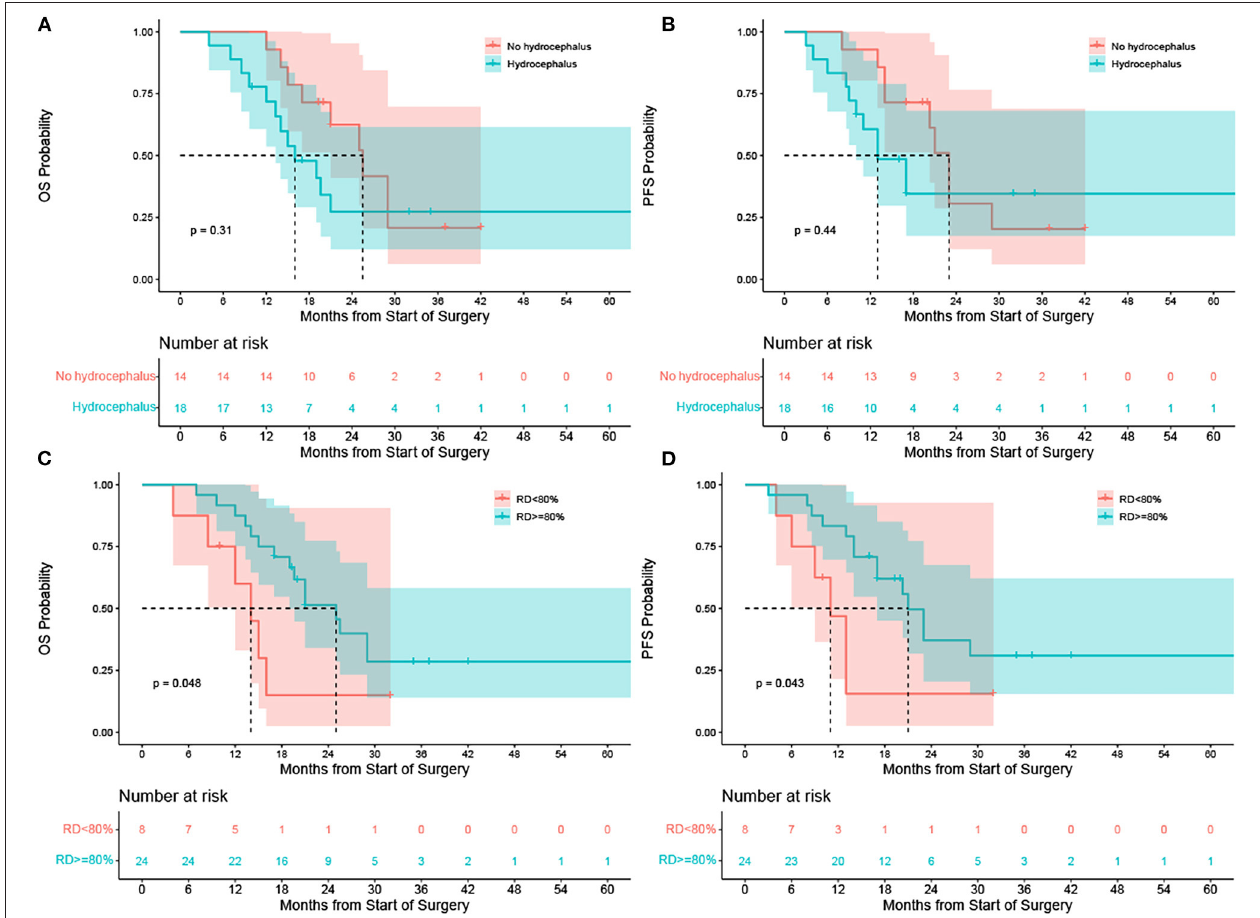
FIGURE 5 | (A) Correlation of overall survival after tumor resection with early hydrocephalus in the glioblastoma group (green line: no hydrocephalus in the early postoperative period, blue line: hydrocephalus in the early postoperative period). The results showed that there was no correlation between early postoperative hydrocephalus and overall survival rate; p = 0.31. (B) Correlation between progression-free survival after tumor resection and early hydrocephalus in the glioblastoma group (green line: no hydrocephalus in the early postoperative period; blue line: hydrocephalus in the early postoperative period). The results show that there was no correlation between early postoperative hydrocephalus and progression-free survival rate; p = 0.44. (C) Correlation between tumor resection degree and overall survival rate in the glioblastoma group (green line: resection degree ≥ 80%; blue line: resection degree < 80%). The results showed that full resection of lesions improved the overall survival rate (OS); p = 0.048. (D) Correlation between tumor resection degree and progression free survival rate in the glioblastoma group (green line: resection degree ≥ 80%; blue line: resection degree < 80%). The results showed that full resection of lesions improved the total progression free survival (PFS); p =